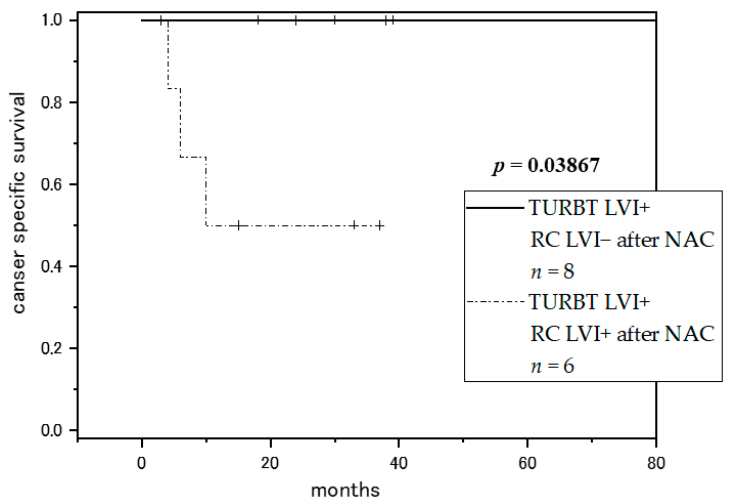
Figure 3. Kaplan-Meier curves for cancer-specific survival in the patients who were diagnosed with LVI + at TURBT and underwent NAC, RC LVI − vs. RC LVI+. LVI: lymphovascular invasion; TURBT: transurethral resection of bladder tumor; RC: radical cystectomy.